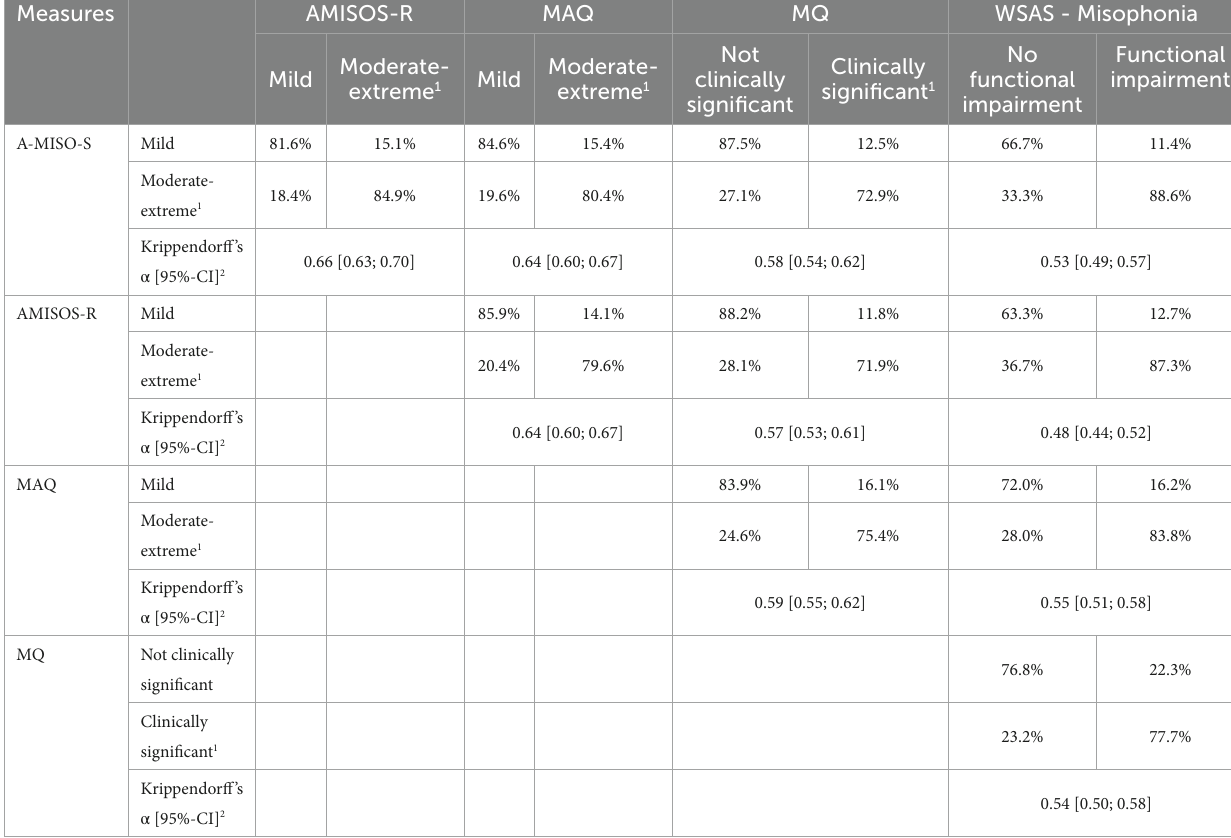
TABLE 2 Concordance rates and chance-corrected agreement coefficient based on binary categorization per measure. Measures